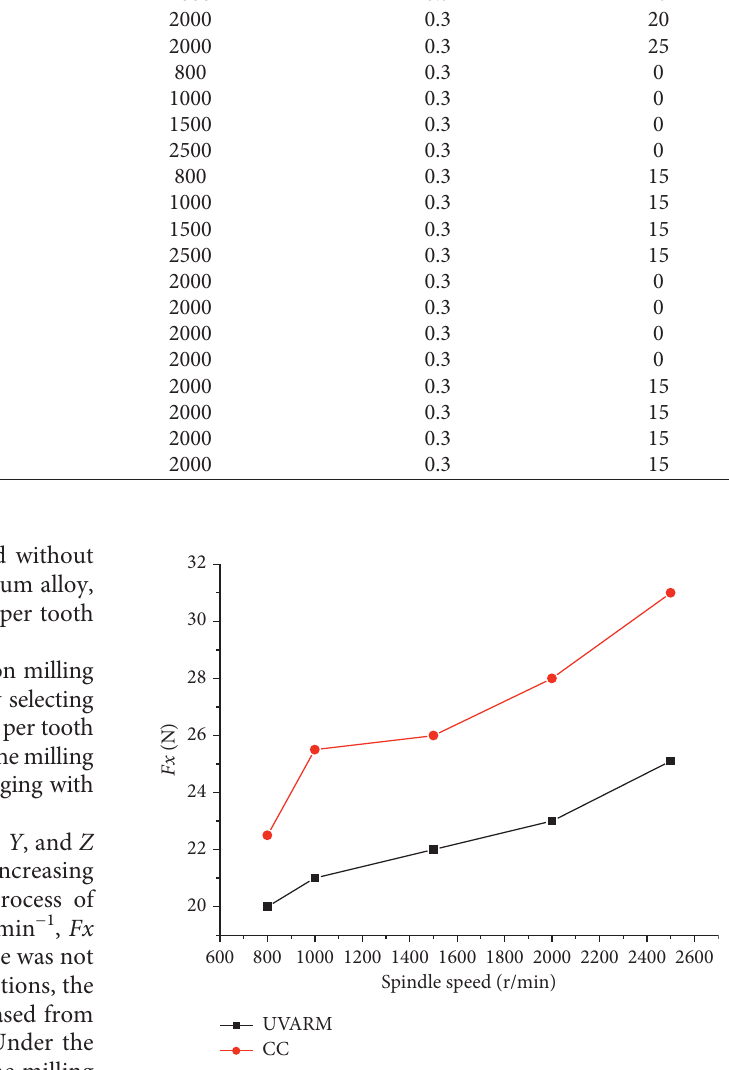
Figure 9: Fx changes with the spindle